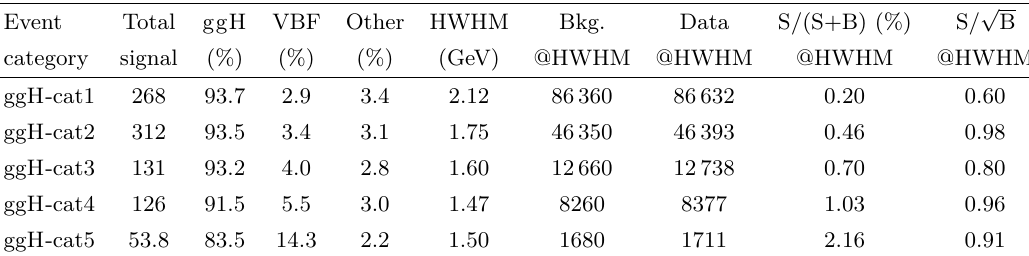
Table 4 . The total expected number of signal events with m expected contributions from different production modes to the total signal yield (“Other” represents the sum of VH , ttH , and bbH contributions), the HWHM of the signal peak, the estimated number of background events (B) and the observation in data within ± HWHM , and the S/(S+B) and the √ S / B ratios within ± HWHM , for each of the optimized ggH event